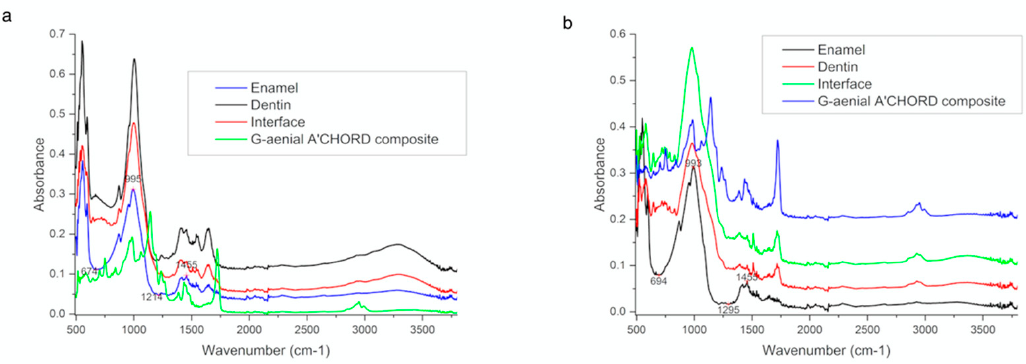
Figure 8. FTIR spectrum based on the restorative layering technique: ( a )- oblique layering technique; ( b )- horizontal layering technique.